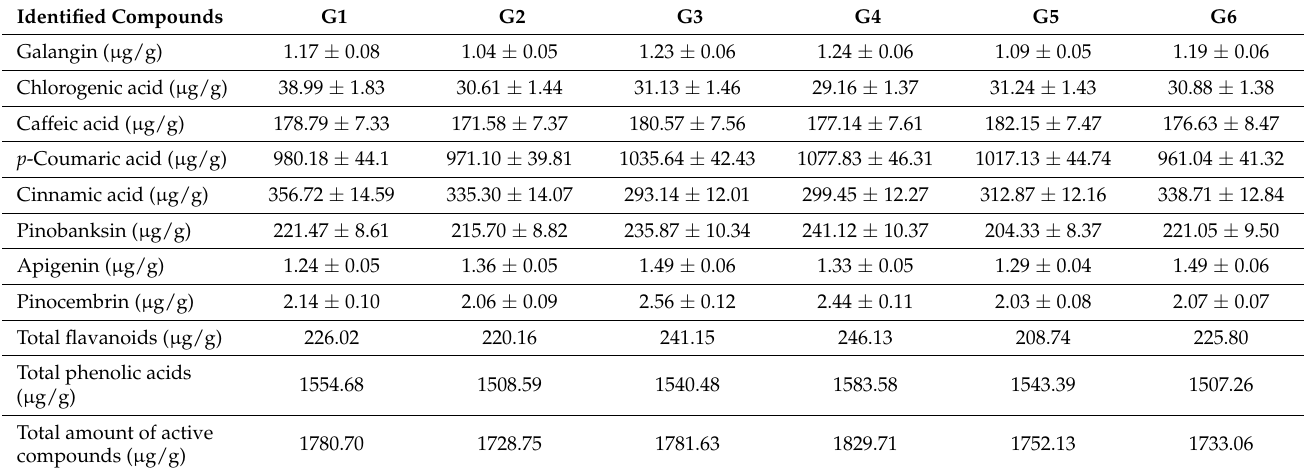
Table 6. HPLC analysis results for in situ gels G1–G6 (mean µg/g ± SD, n = 3).